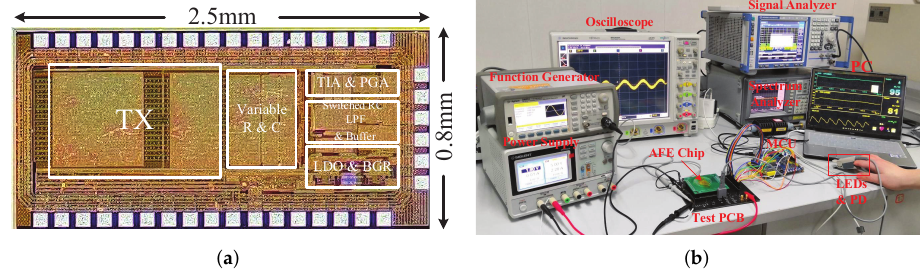
Figure 10. ( a ) The chip micrograph of the proposed AFE system. ( b ) Experimental setup for the proposed AFE